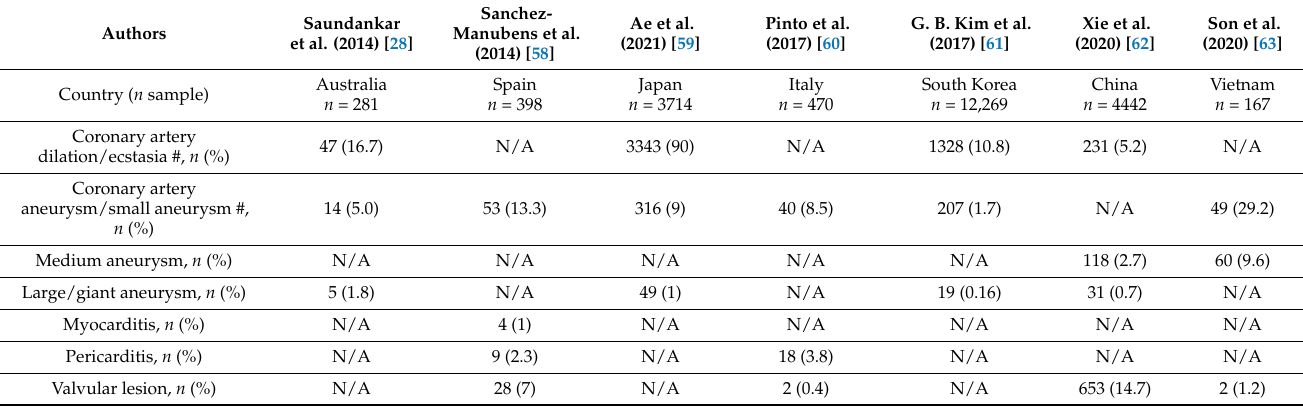
Table 1. Summary findings of cardiac manifestation from different studies